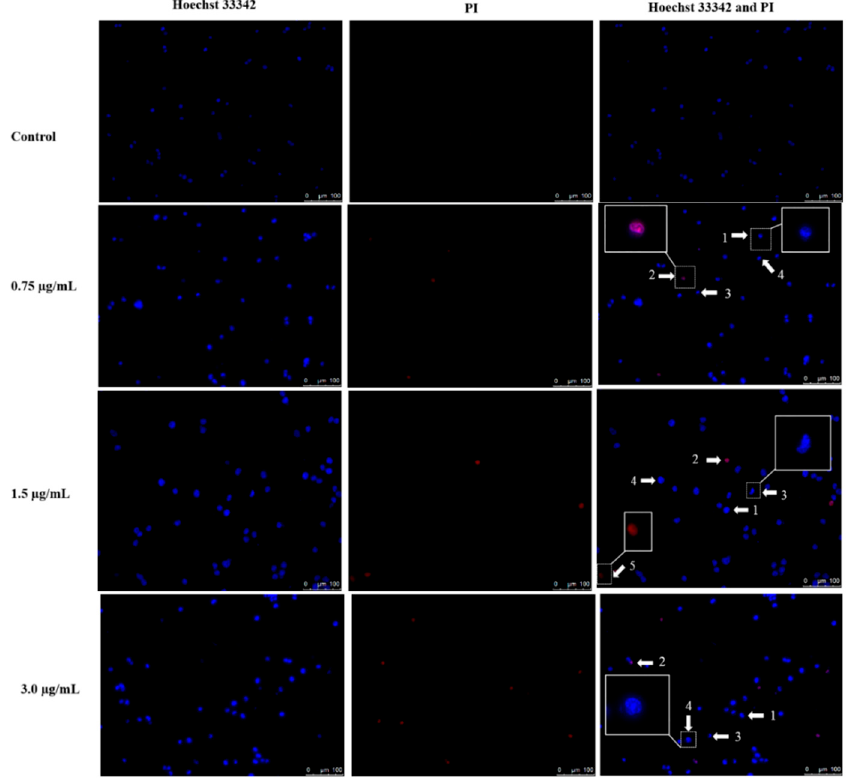
Figure 3. Effect of deoxyelephantopin on nuclear morphological changes of HCT116 cells. After exposure to 0.75 µg/mL, 1.5 µg/mL and 3.0 µg/mL of DET at 24 h, cells were stained with Hoechst 33342 and PI followed by observation under fluorescence microscope. Magnification: 200× Arrow 1 chromatin condensation, 2 late apoptosis, 3 cell shrinkage, 4 DNA fragmentation, 5 necrosis.